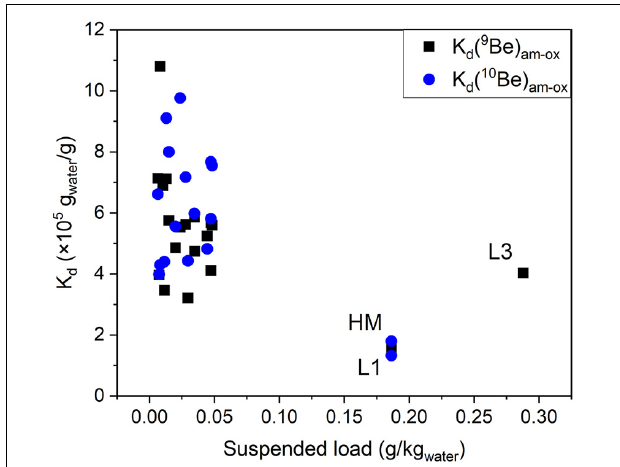
FIGURE 2 | Partition coefficient ( K d ) of 9 Be and 10 Be versus suspended load. Three bottom waters (HM, L1, and L3) with high suspended load and low K d values are marked.